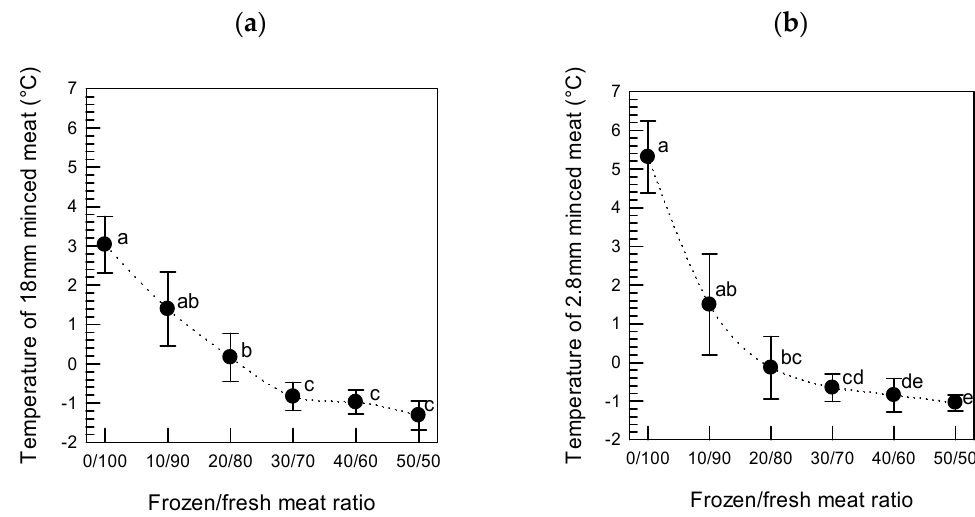
Figure 2. Temperature of 18 mm-minced meat after the first mincing step ( a ) and 2.8 mm-minced meat after the second mincing step ( b ) (n = 30) (mean ± standard deviation) of minced meat with varying frozen to fresh meat ratios. Different letters indicate significant differences ( p < 0.05).